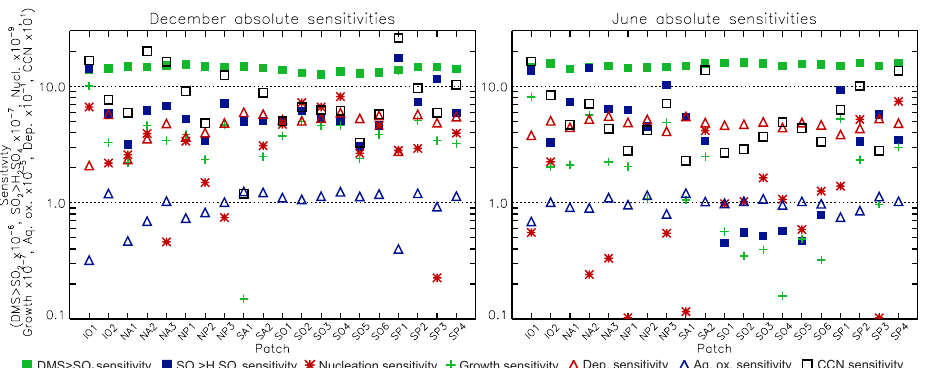
Fig. 6. Absolute sensitivities of processes and CCN. Absolute sensitivities for the different processes cover sev- eral orders of magnitude, and are accounted for by multiplying the value from the plot by the scaling indicated on the y-axis.